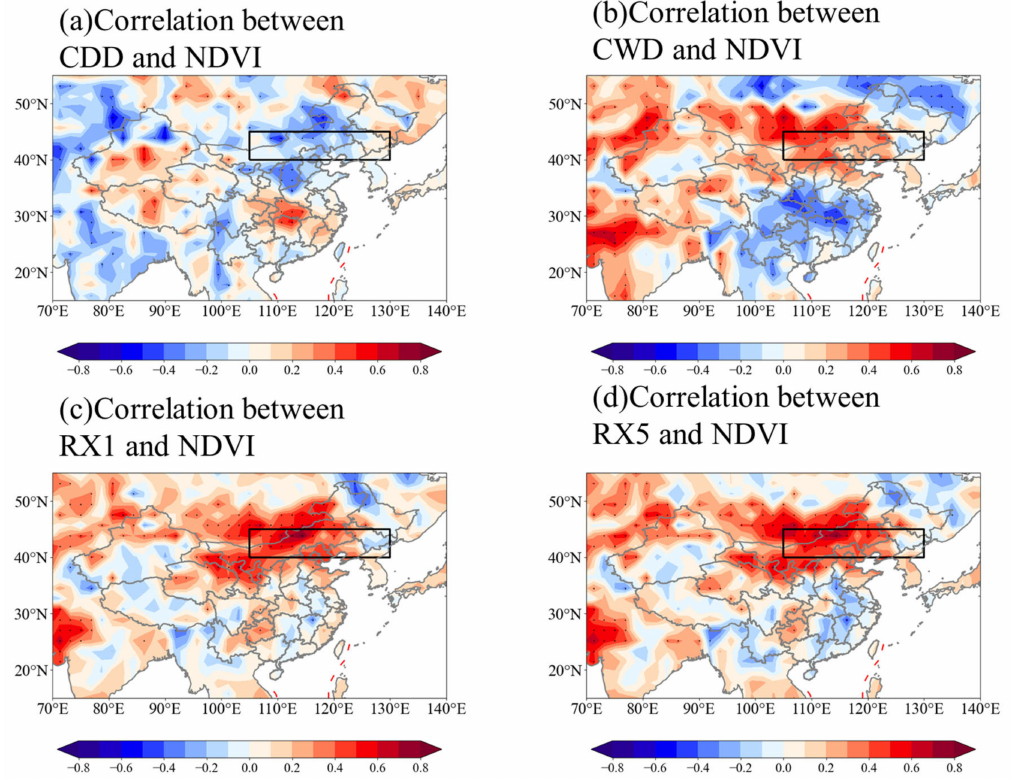
Figure 11. Spatial correlations (grid-to-grid correlation) between NDVI and four extreme indexes related to precipitation: ( a ) CDD (days)–NDVI, ( b ) CWD (days)–NDVI, ( c ) RX1day (mm)–NDVI, ( d ) RX5day (mm)–NDVI. Note: red represents positive correlation, blue represents negative cor- relation. The red dashed lines in the figure represent Ten-dashed lines. The numbers below the description of the colors represent the spatial correlation coefficients. The black box in it is defined as the northeastern region of East Asia (40~45 ◦ N, 105~120 ◦ E). Dots represent significance at p < 0.1, and in the dotted areas, the effective degree of freedom varies spatially between